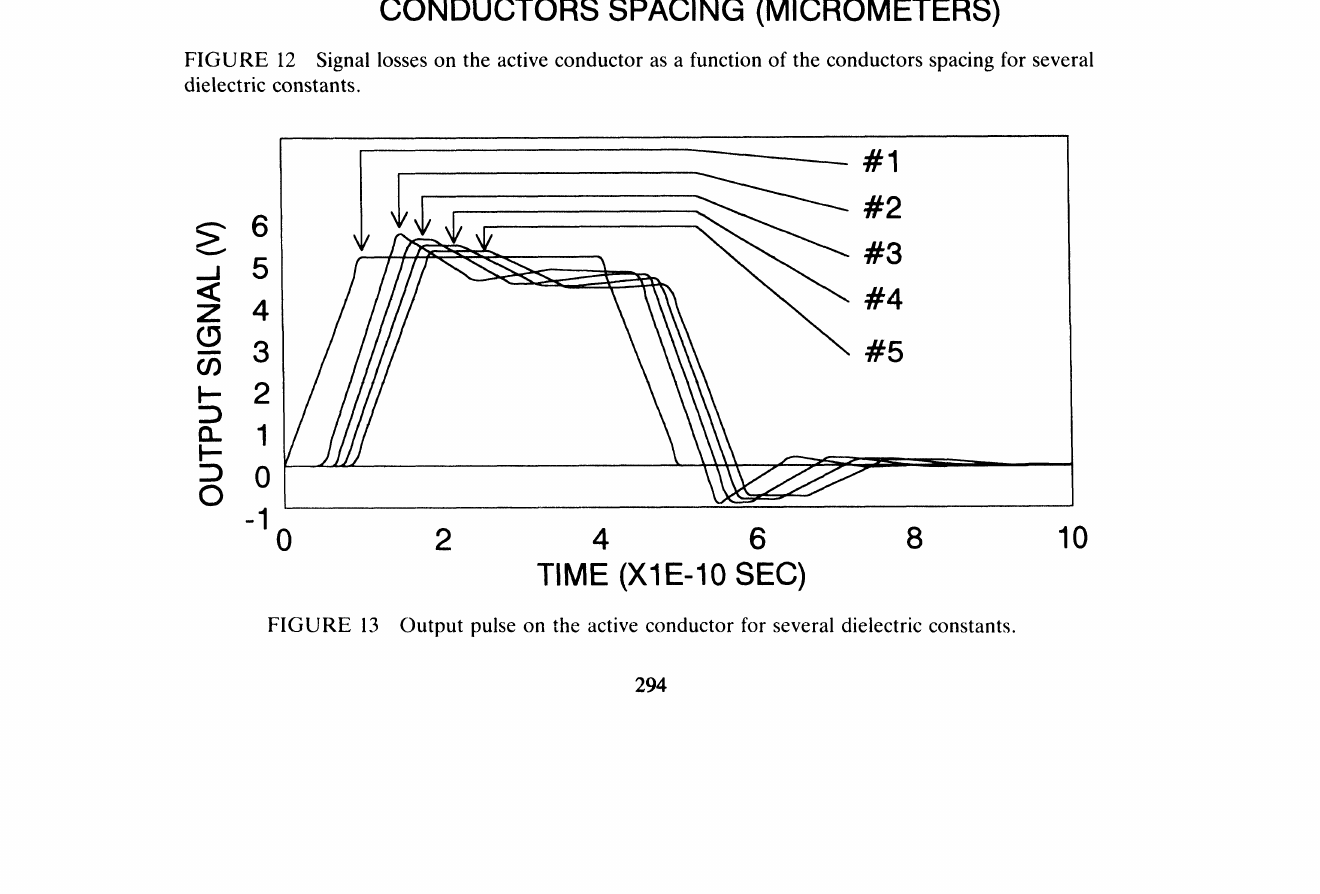
FIGURE 12 Signal losses on the active conductor as a function of the conductors spacing for several dielectric constants.